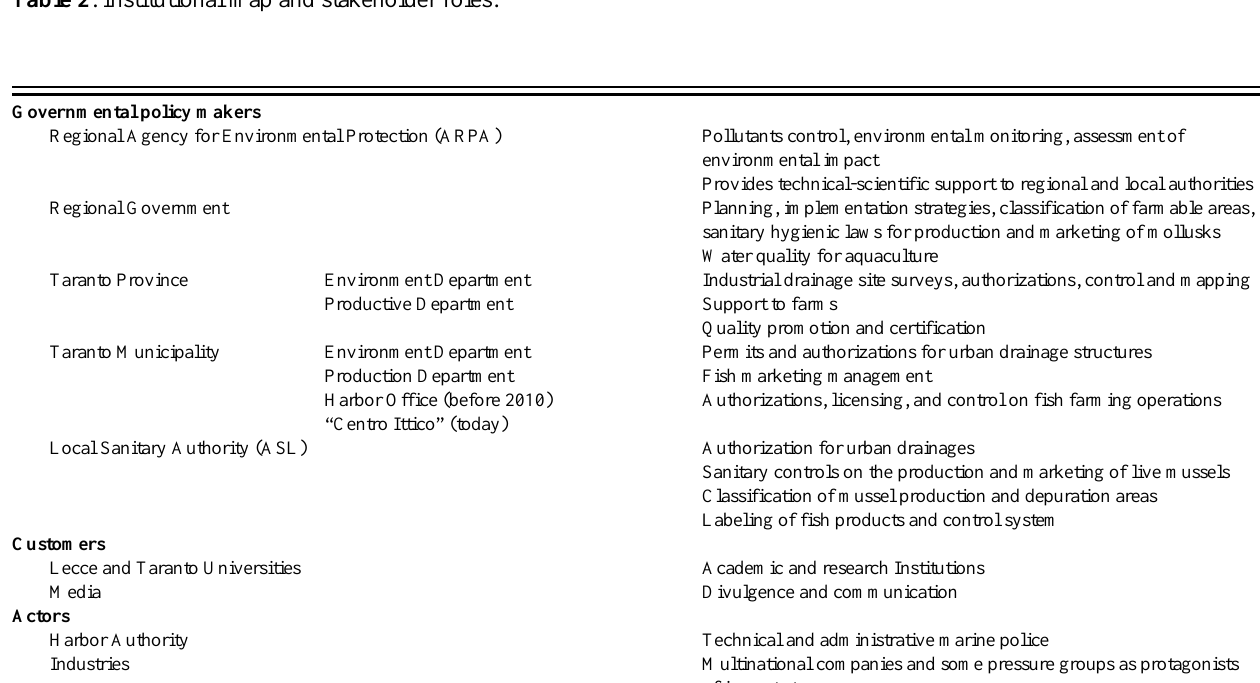
Table 2 . Institutional map and stakeholder